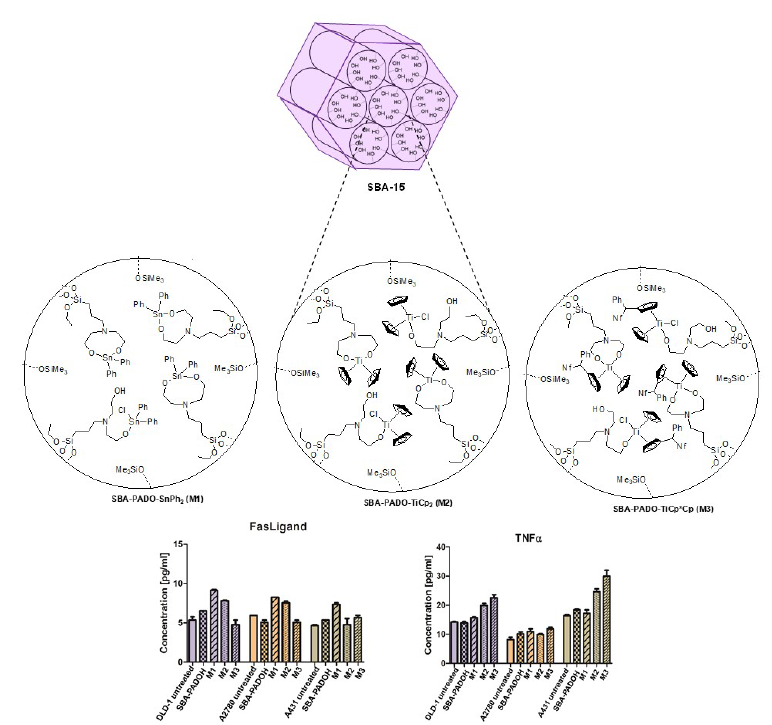
Figure 6. Synthesis of tin- and titanium-functionalized SBA-15 materials and mechanism of pro- grammed cell death. Adapted from reference [73]. Reproduced with permission. Copyright © Royal Society of Chemistry.